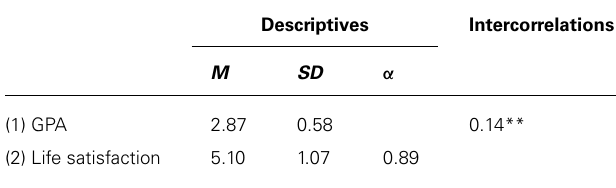
Table 3 | Regression of LS on students’ grades, examining the moderating effect of mothers’ education (Model 1) and fathers’ education (Model 2).